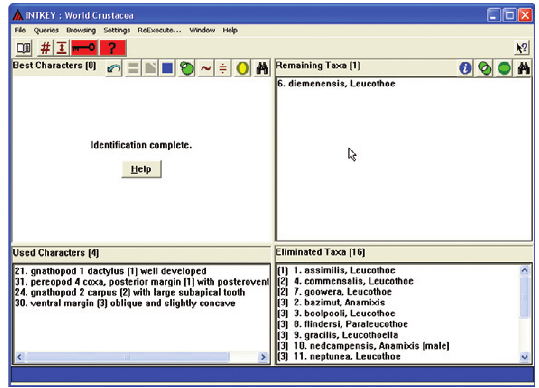
Figure 70. Th e identifi cation sequence for one part of the key is complete. Now we go back a few steps to continue to work on the key.